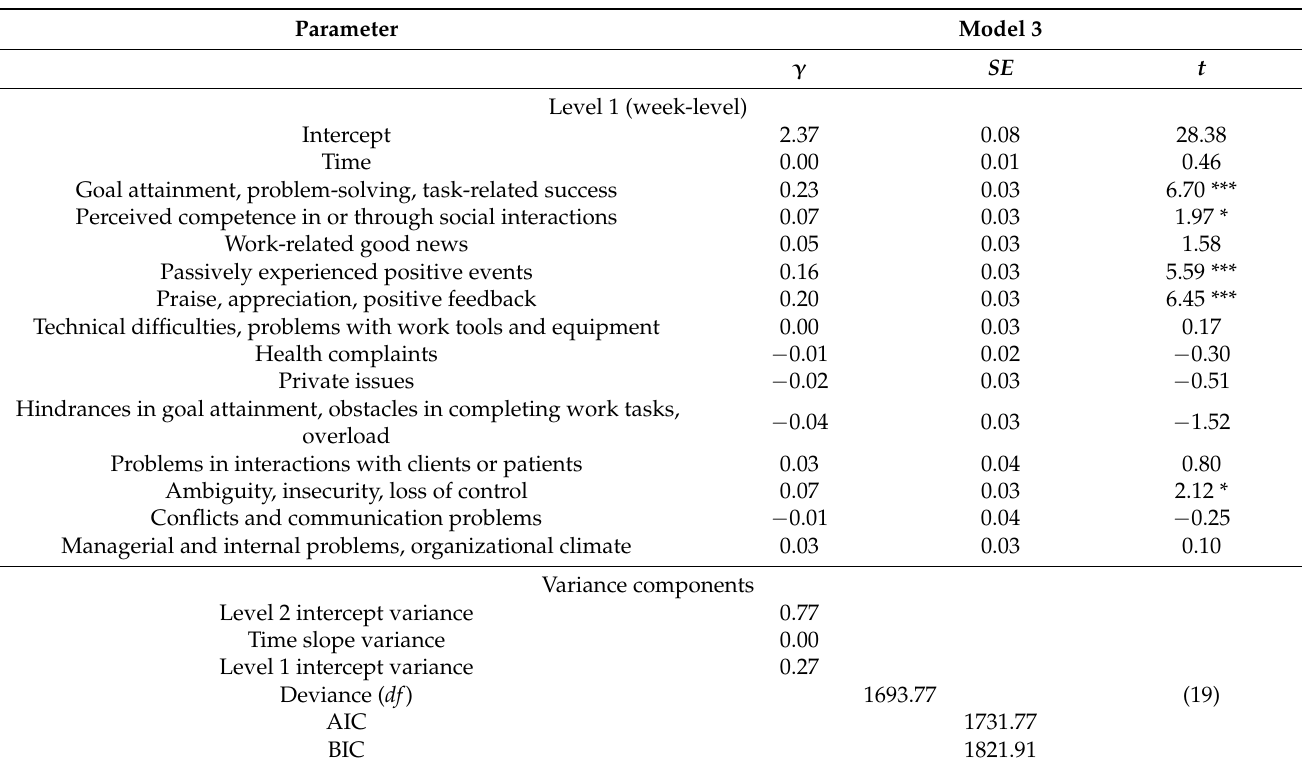
Table 5. Results from Multilevel Analysis Predicting Work Engagement by Specific Positive and Negative Events Within the Same